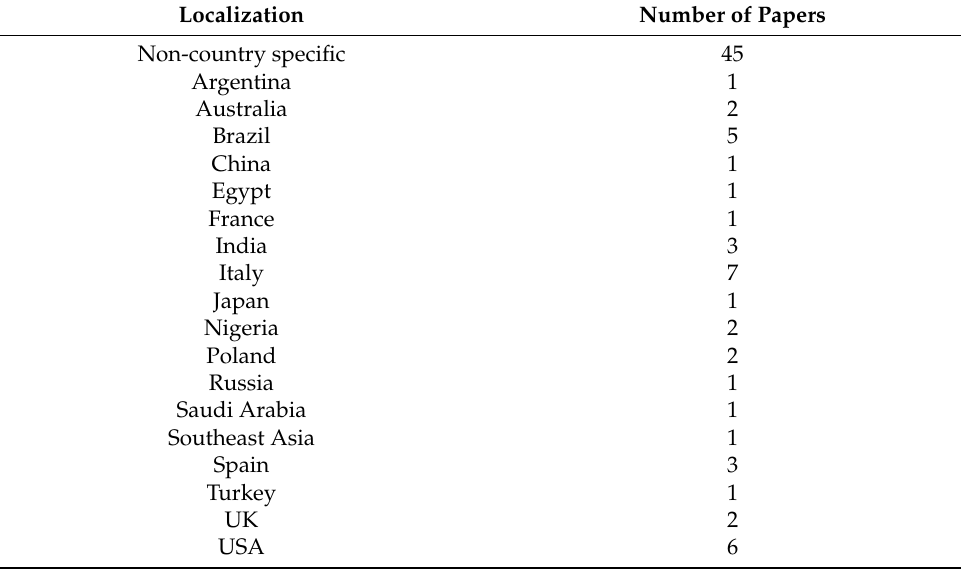
Table 2. Allocation of the